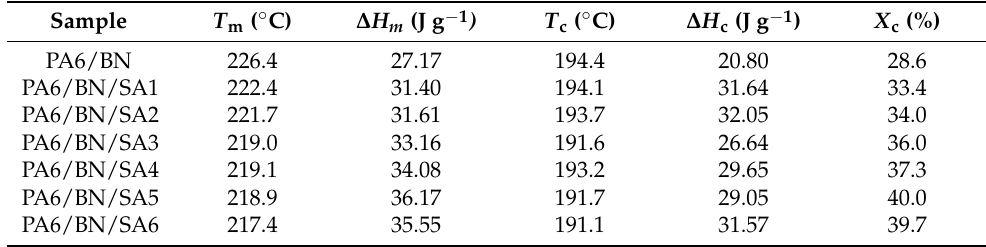
Figure 4. DSC curves of ( a ) cooling and ( b ) secondary heating of composites. Table 2. DSC data of